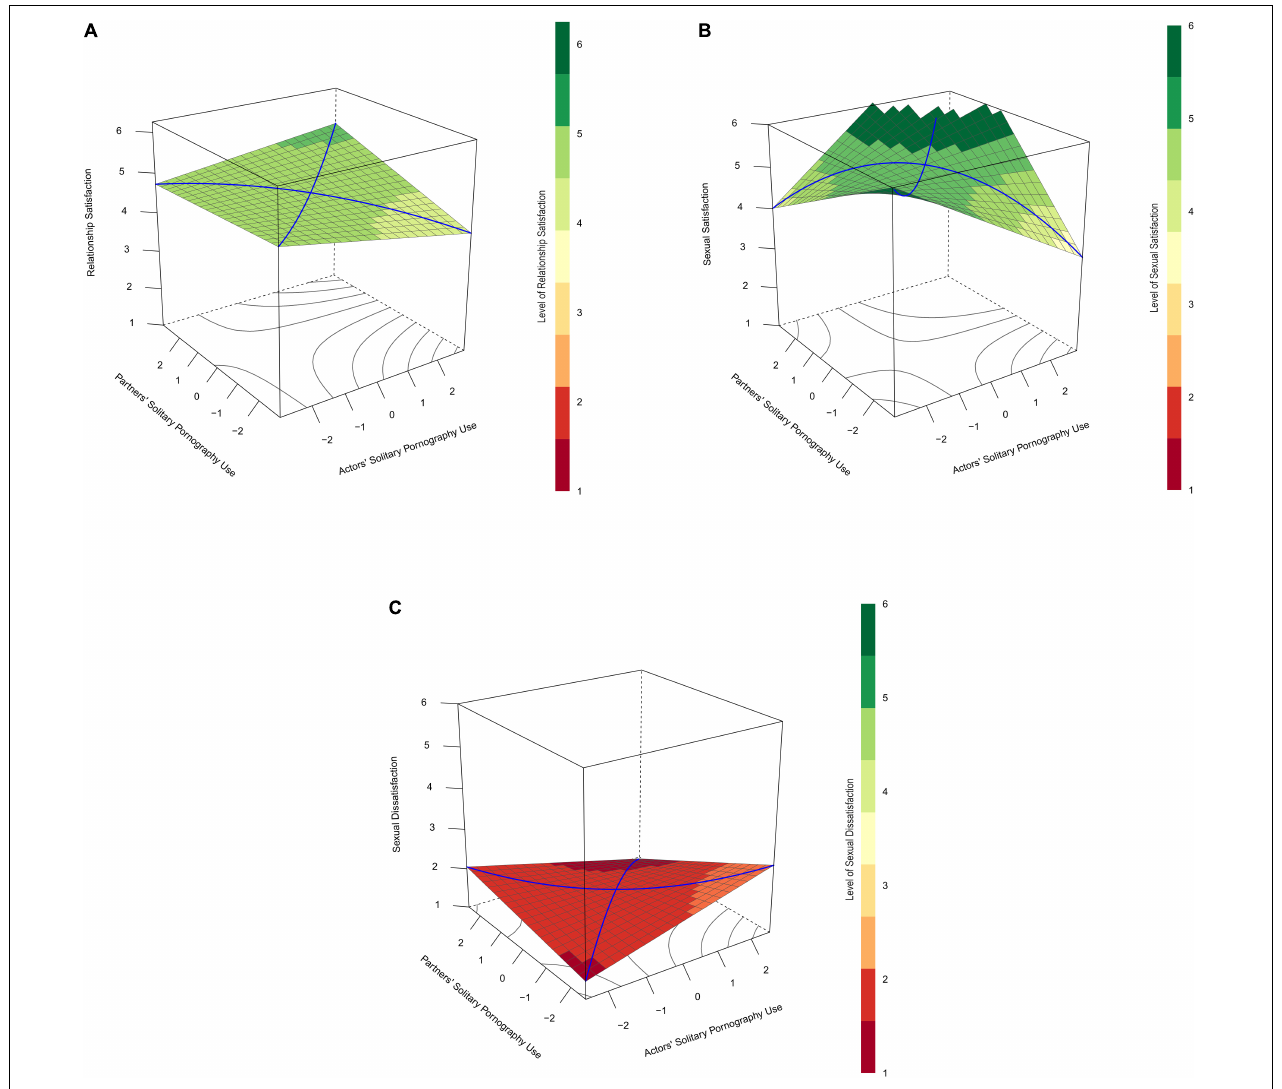
FIGURE 5 | (A) Depicts predicted relationship satisfaction (vertical axis) as a function of actors’ ( x -axis) and partners’ ( y -axis) frequencies of solitary pornography use and their interaction for cases that reported mean levels of shared pornography use in Study 4. (B,C) Do the same for the prediction of sexual satisfaction and sexual dissatisfaction, respectively. In (A) , the lack of significant interaction resulted in a flatter prediction surface where partners with dissimilar frequencies of solitary pornography use were not notably lower in relationship satisfaction than partners with more similar frequencies. In (B) , sexual satisfaction scores tended to be lowest in cases in which couple members were most dissimilar in their frequencies of solitary pornography use (left- and right-most corners of the plots). According to regions of significance tests, participants’ own solitary pornography use was negatively related to their relationship satisfaction if their partners’ used pornography alone less than 1.80 times a week but was otherwise unrelated. Conversely, in (C) , sexual dissatisfaction scores tended to be highest in cases in which couple members were most dissimilar in their frequencies of solitary pornography use (left- and right-most corners of the plots). According to regions of significance tests, participants’ solitary pornography use was positively related sexual dissatisfaction if their partner indicated that they used pornography less than 2.17 times a week, otherwise their pornography use was unrelated to their sexual